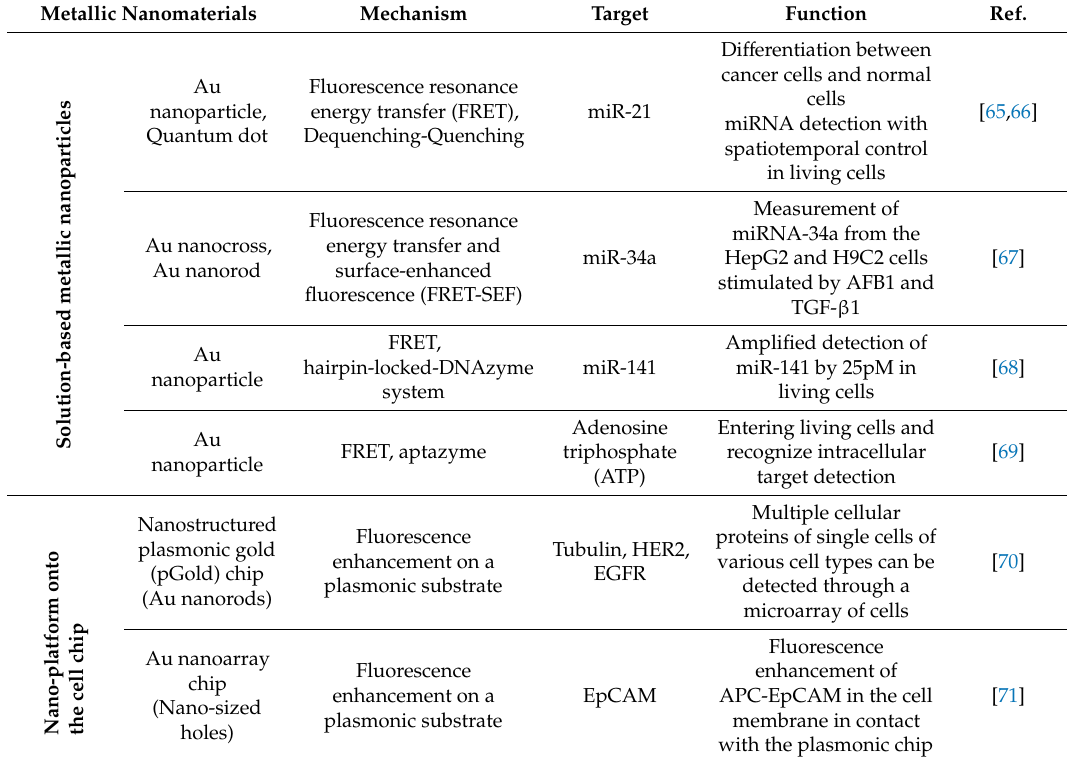
Table 1. Fluorescence-based analytical platforms for cell analysis with metallic nanomaterials. Metallic